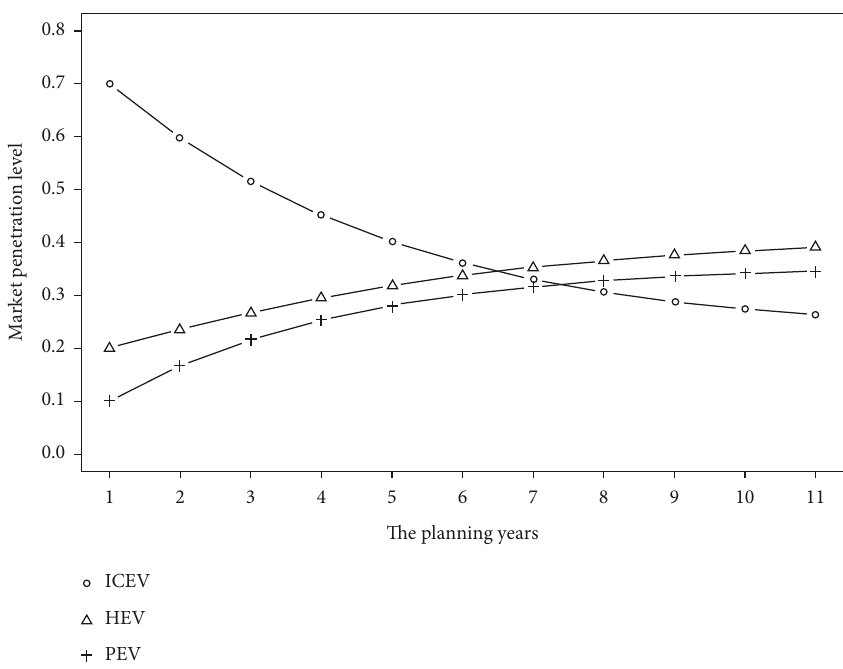
Figure 4: The dynamics of market penetration level in the future. Table 3: The dynamic environmental impact along with energy structural